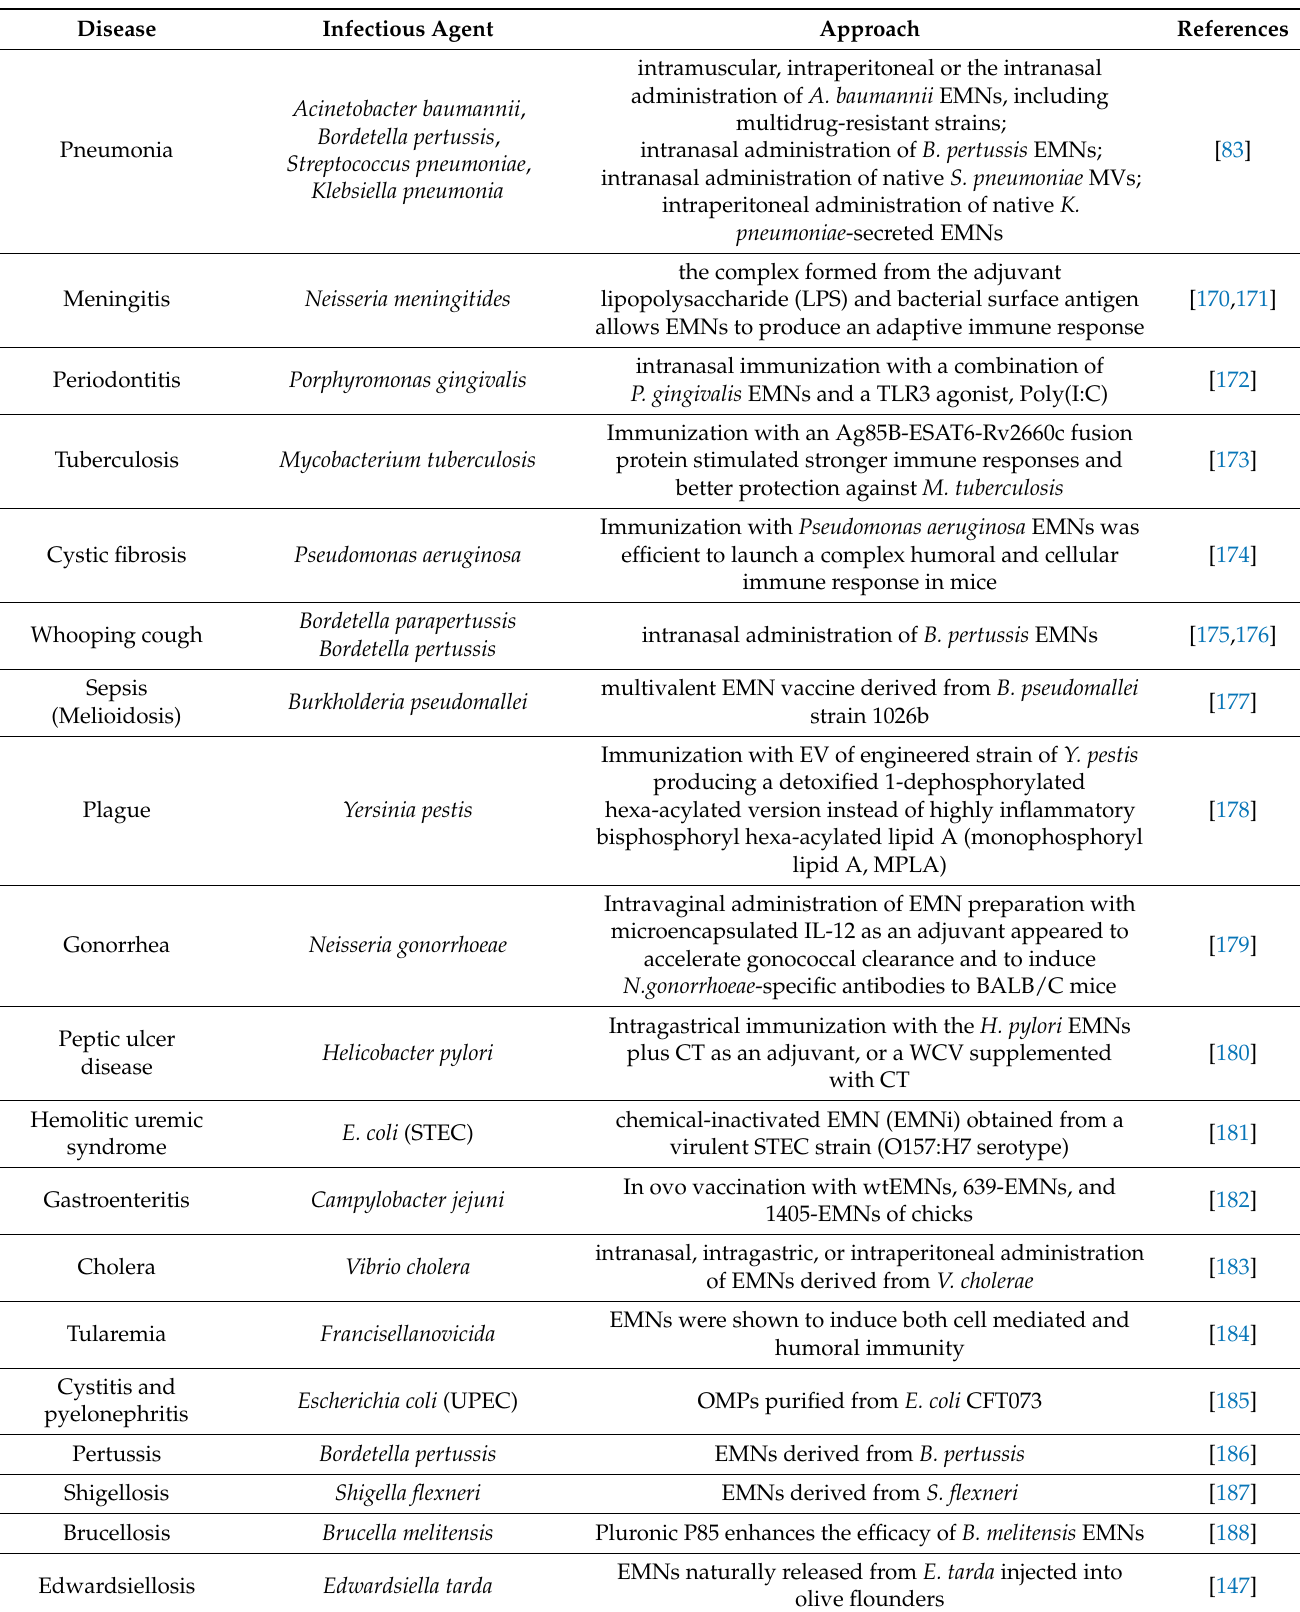
Table 1. Vaccine candidates developing on the basis of EMN against diverse pathogenic